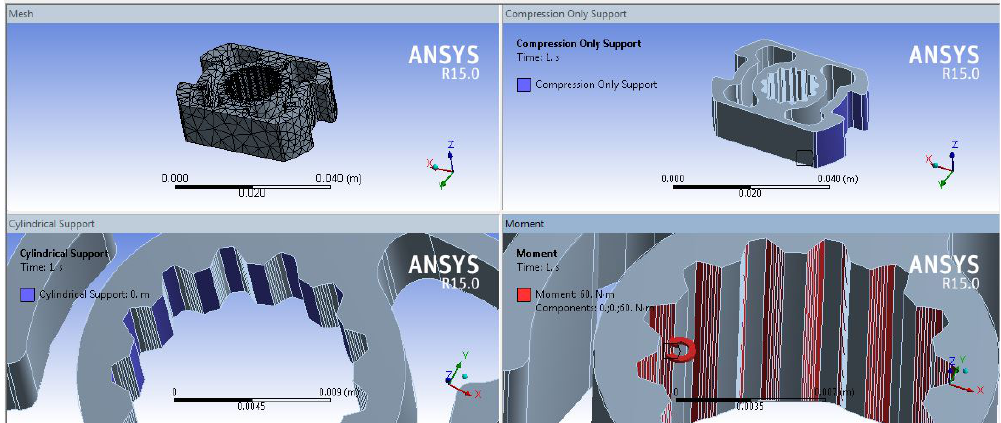
Figure 9. Finite element model: ( top left ) the mesh; ( top right ) the contact constraint between the sensor and the case; ( bottom left ) the fix constraint; ( bottom right ) the applied torque.